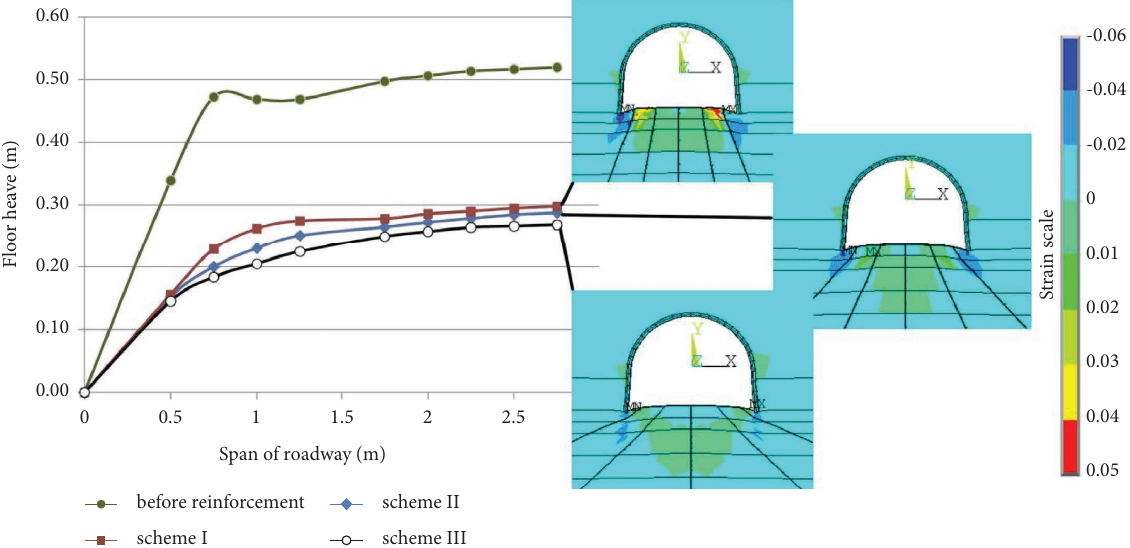
Figure 20: Floor heave on monitoring line B-B 1 and vertical plastic strain distribution around the roadway before and after reinforcement with diferent foor support